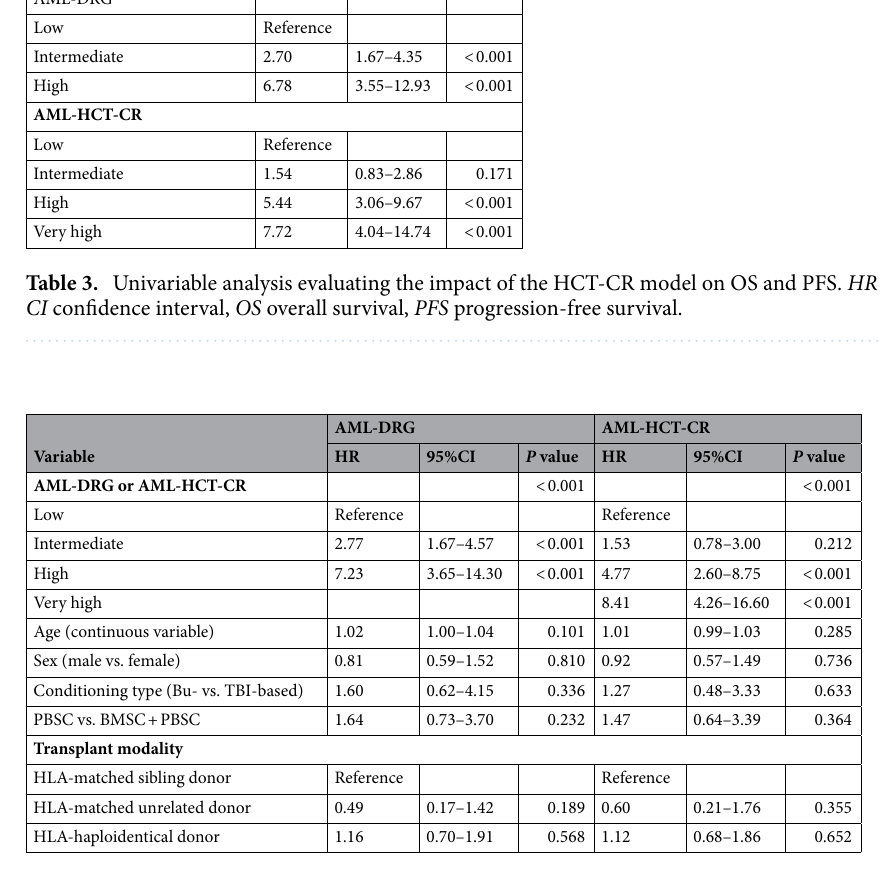
Table 4. Multivariable analysis for OS. HR hazard ratio, CI confidence interval, BMSC bone marrow stem cell, PBSC peripheral blood stem cell, Bu Busulfan, TBI total body